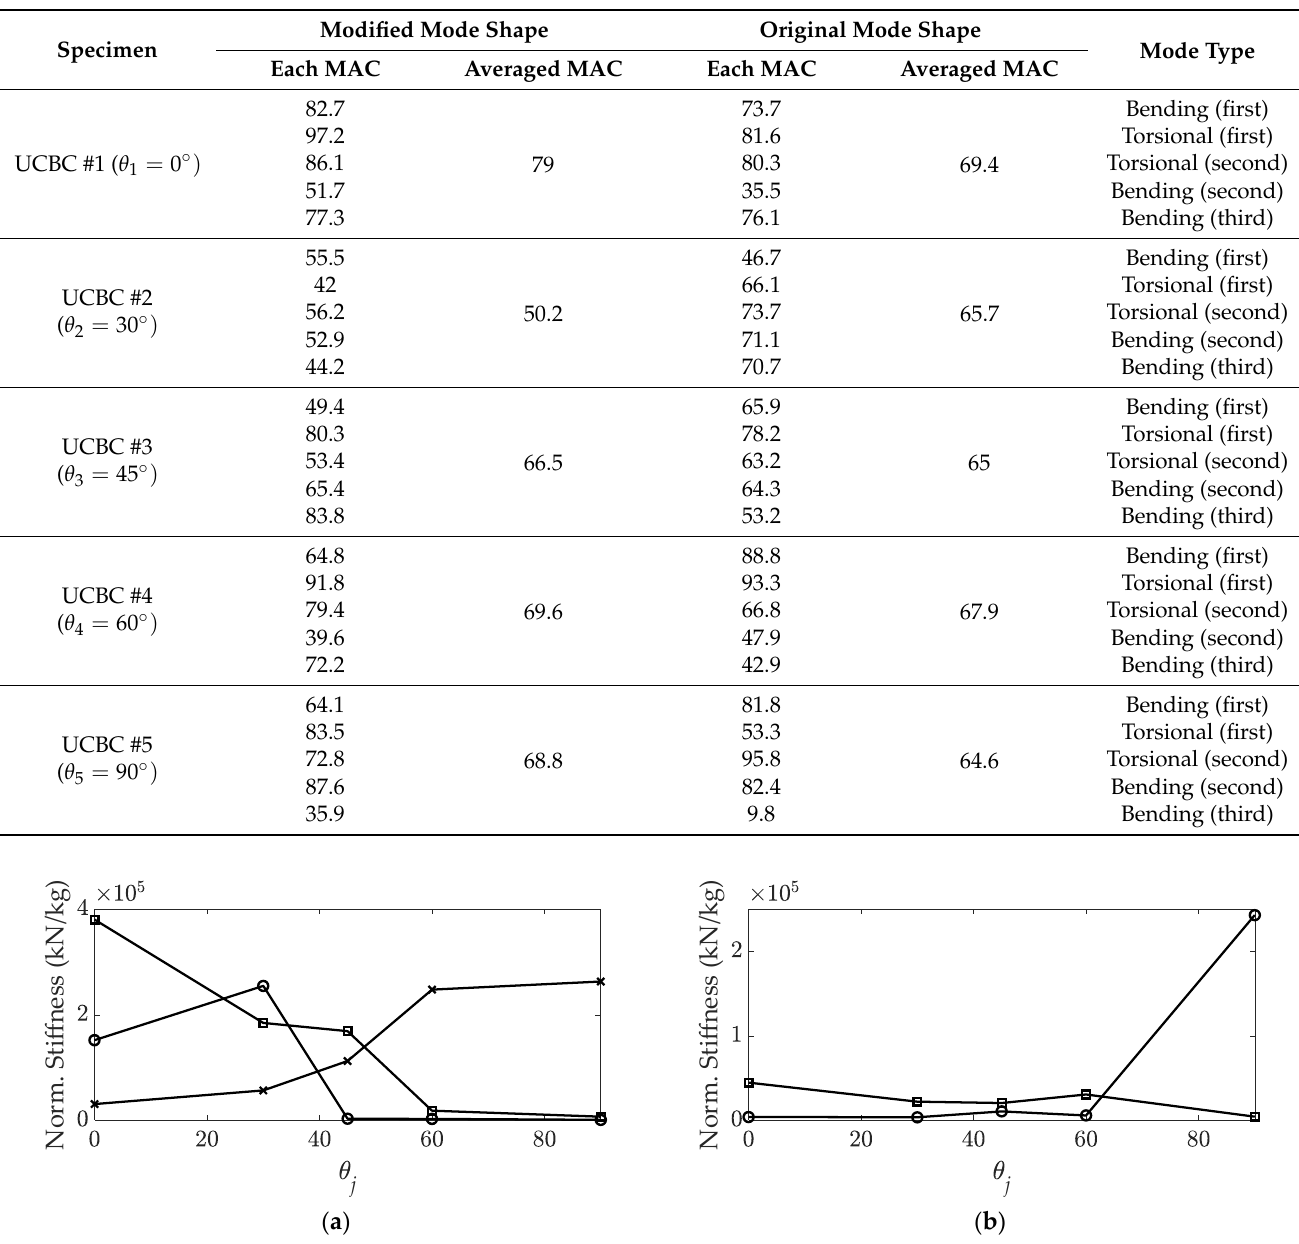
Table 3. Modal parameters and MAC values of UCBC specimens.